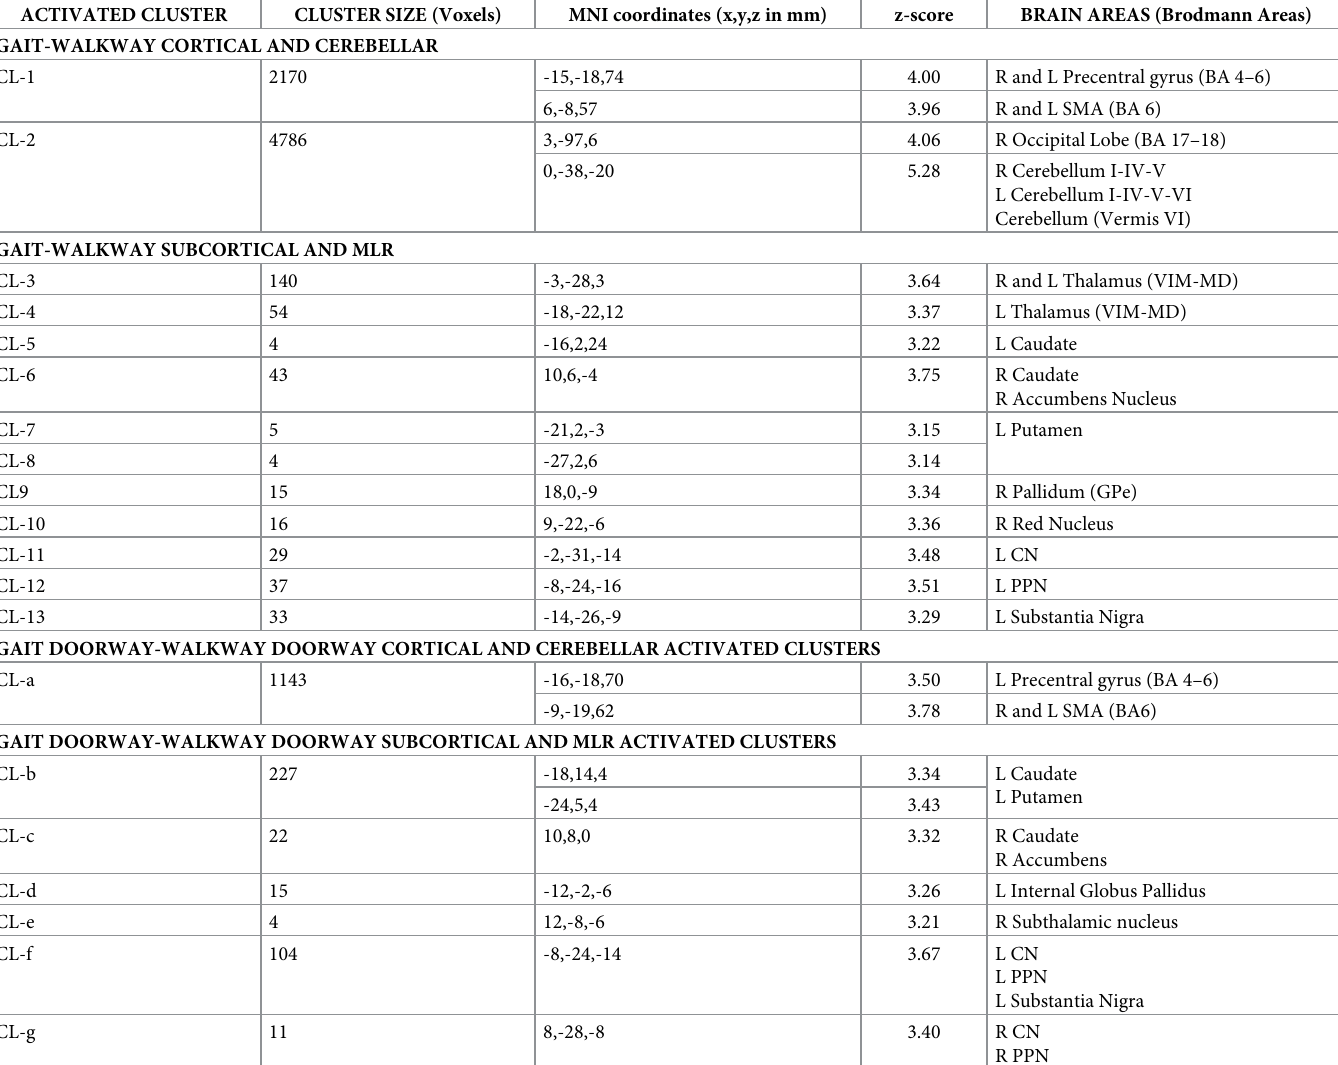
Table 1. Activated clusters found in the brain regions for the contrasts GAIT-WALKWAY and GAIT DOORWAY-WALKWAY DOORWAY. ACTIVATED CLUSTER